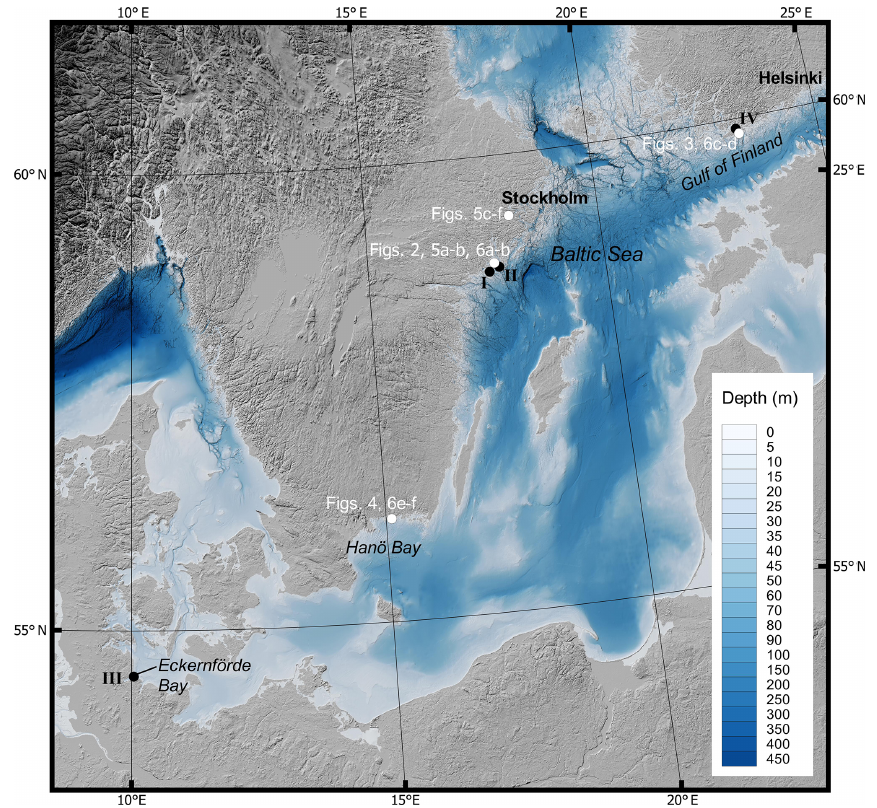
Figure 1. Overview map showing the locations of the studied areas in this work with white dots. Corresponding figures for each area are shown with white text. The locations of previous studies showing SGD discussed here are shown with black dots. I and II: Söderberg and Flodén (1997); III: Schlüter et al. (2004); IV: Virtasalo et al. (2019). The bathymetry is from EMODnet 2018 (EMODnet Bathymetry Consortium,